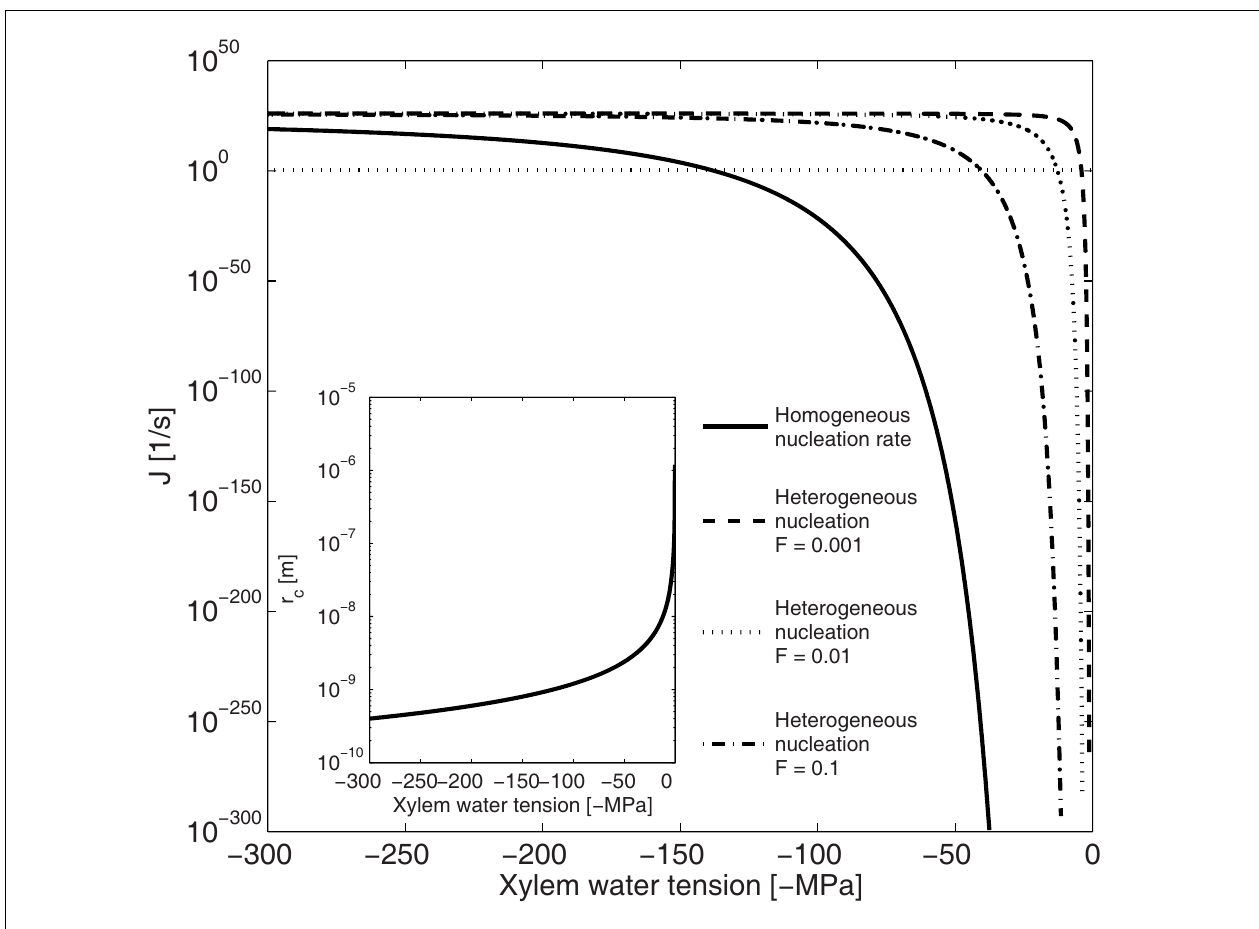
energy barrier for nucleation (Eq. 2) has to decrease by a factor ( F ; Eq. 8) of 10 for heterogeneous vaporization of water to become likely at xylem water tensions below − 50MPa.The horizontal line shows the nucleation rate at which bubble formation becomes likely in conduits of this size (Eq.